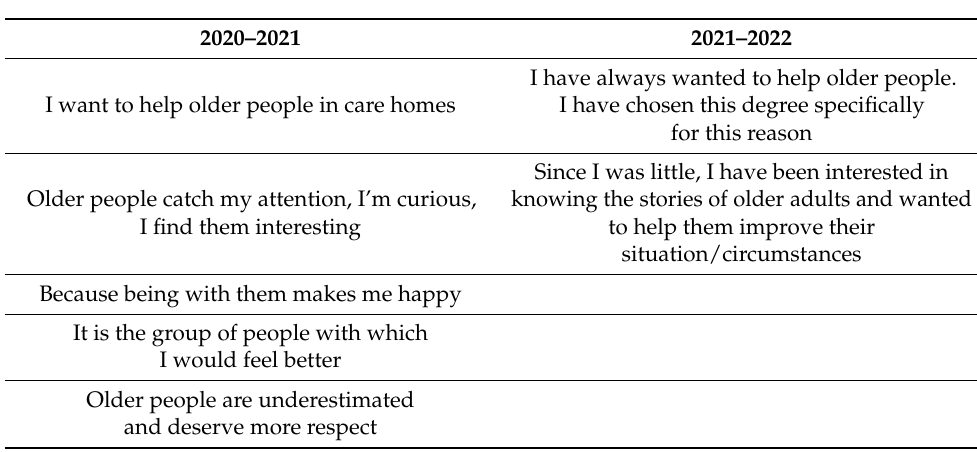
Table 2. Students’ positive motivations.